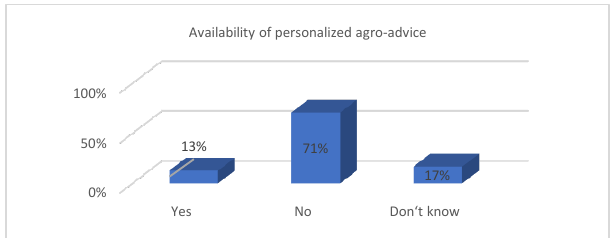
Table 1. The accuracy of agricultural data received from the